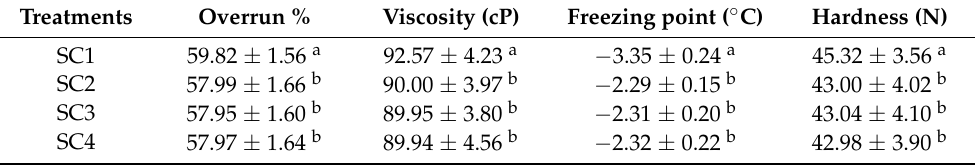
Table 4. Physical analyses of ice cream treatments with stevia, sucralose, and sorbitol (Means ± SE). Treatments Overrun % Viscosity (cP) Freezing point ( ◦ C) Hardness (N)